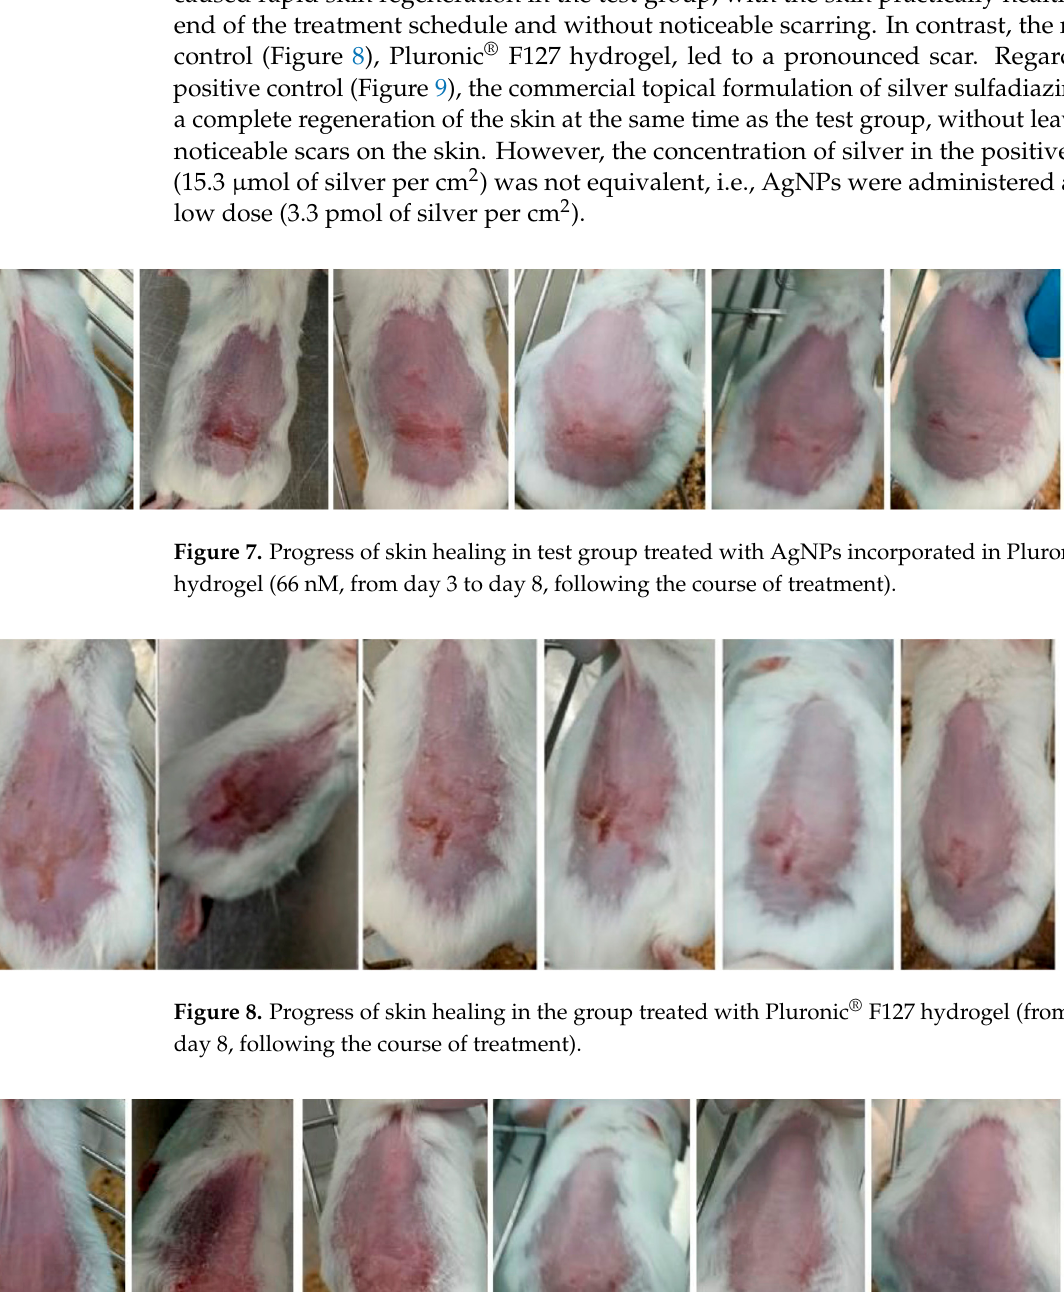
Figure 9. Progress of skin healing in the group treated with the positive control (commercial cream of silver sulfadiazine, 10 mg/g, from day 3 to day 8, following the course of